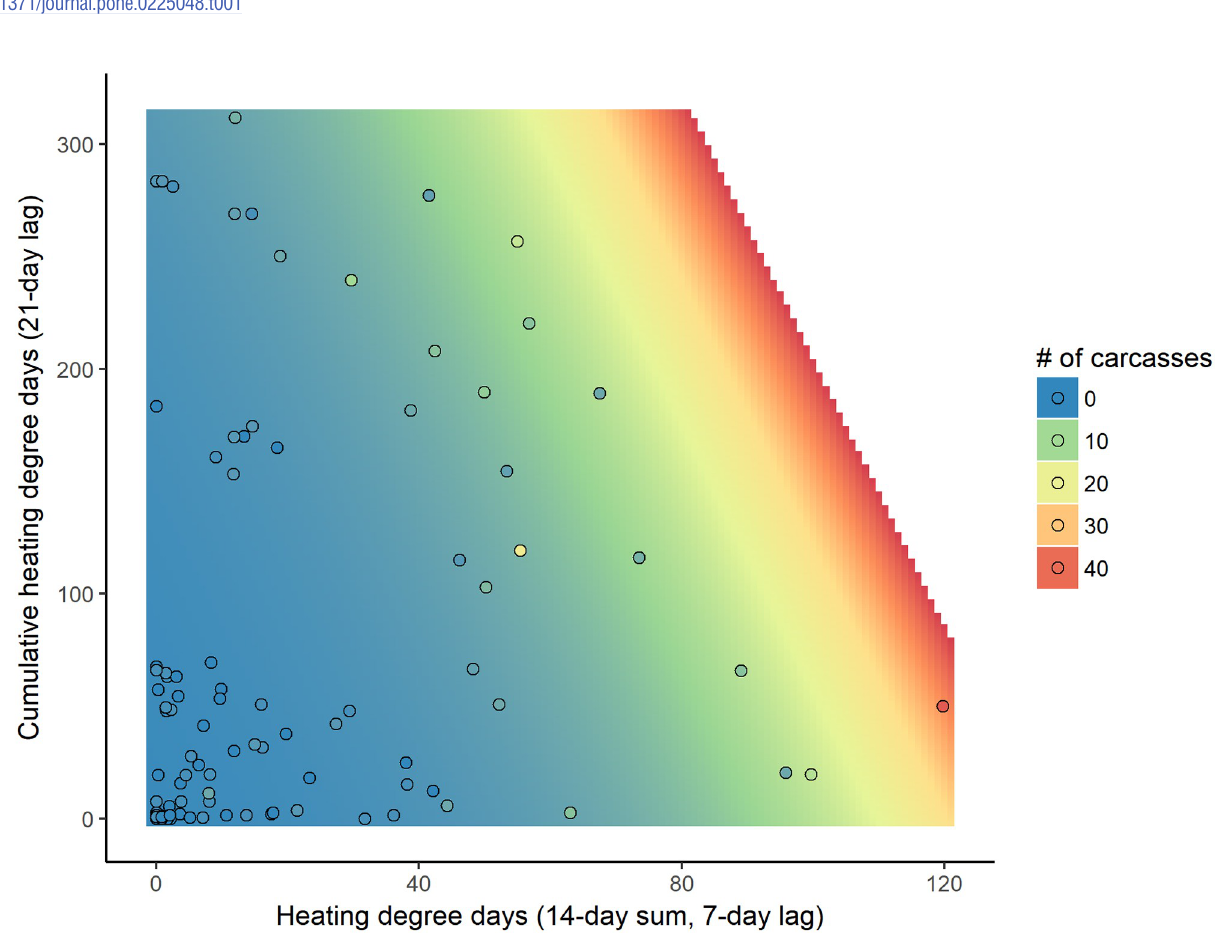
Fig 3. Predicted and observed 7-day counts of cold-related manatee carcasses reported in the central-east (CE) region using water temperature based on the short-term (14-day sum, lagged by 7 days; x-axis) and cumulative temperature effects (lagged by 21 days; y-axis) from the top- ranked model. The background color represents the predicted number of cold-related carcasses reported over 7 days, and the color of the circles represents the observed number of cold-related carcasses reported over 7 days. The scale for the number of carcasses is continuous (from blue to red), but for the ease of visualization, the legend displays the colors at intervals of 10 carcasses. We did not make predictions for the number of expected carcasses above the highest number reported during a 7-day period (area in